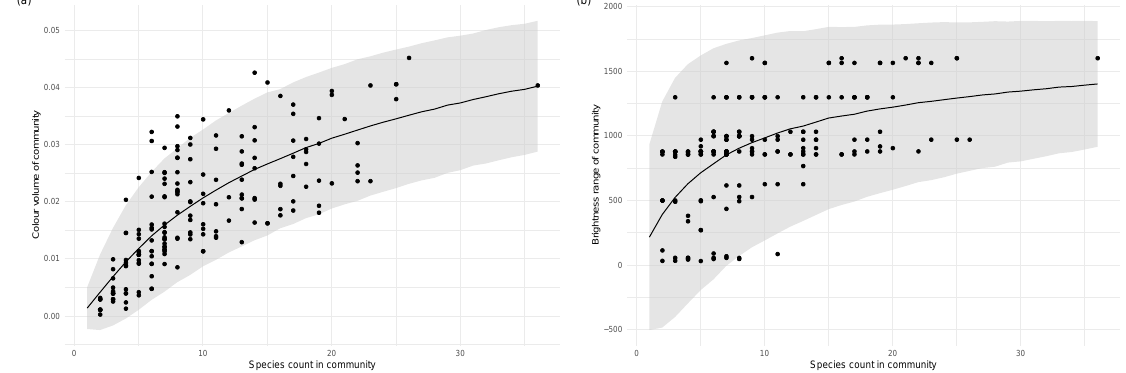
Figure 1 – (a) Community total colour volume and (b) brightness range increase with the number of species within the community. Each point is a community. The black solid line represents the mean value of (a) colour volume or (b) brightness range from 10 000 ran- dom communities with a given species count (null model) and the gray ribbon represents two standard deviations from the mean of the null